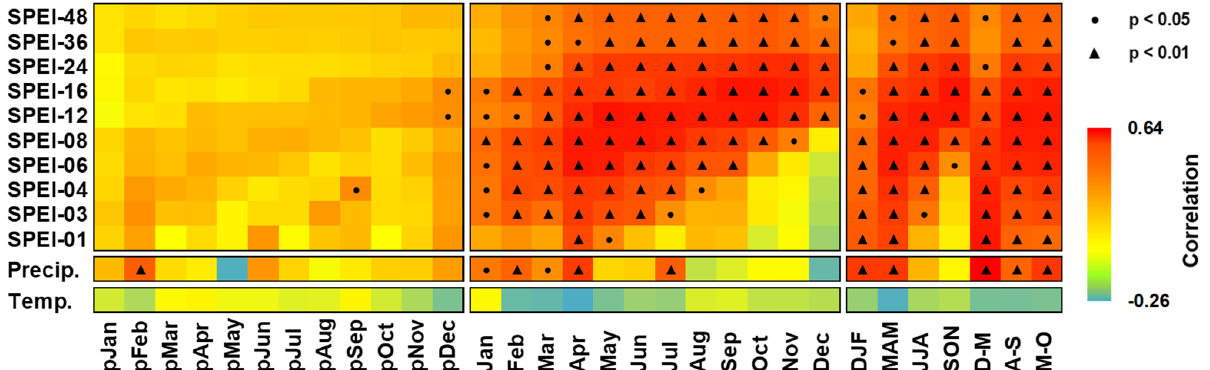
Figure 6. Climate–growth relationships (Pearson correlation coefficients) between the first principal component (i.e., PC1) and temperature, precipitation, and drought index (from SPEI 01 to SPEI 48) over the period 1963–2011. The correlation analysis applied for January of the previous year (pJan)